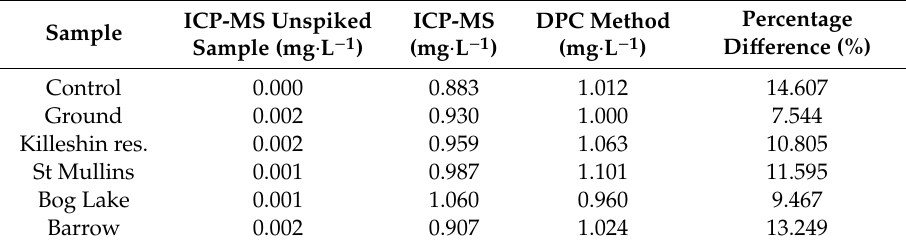
Table 4. A comparison between Cr VI concentrations calculated using the optimised DPC method and measurements obtained from an accredited ICP-MS.